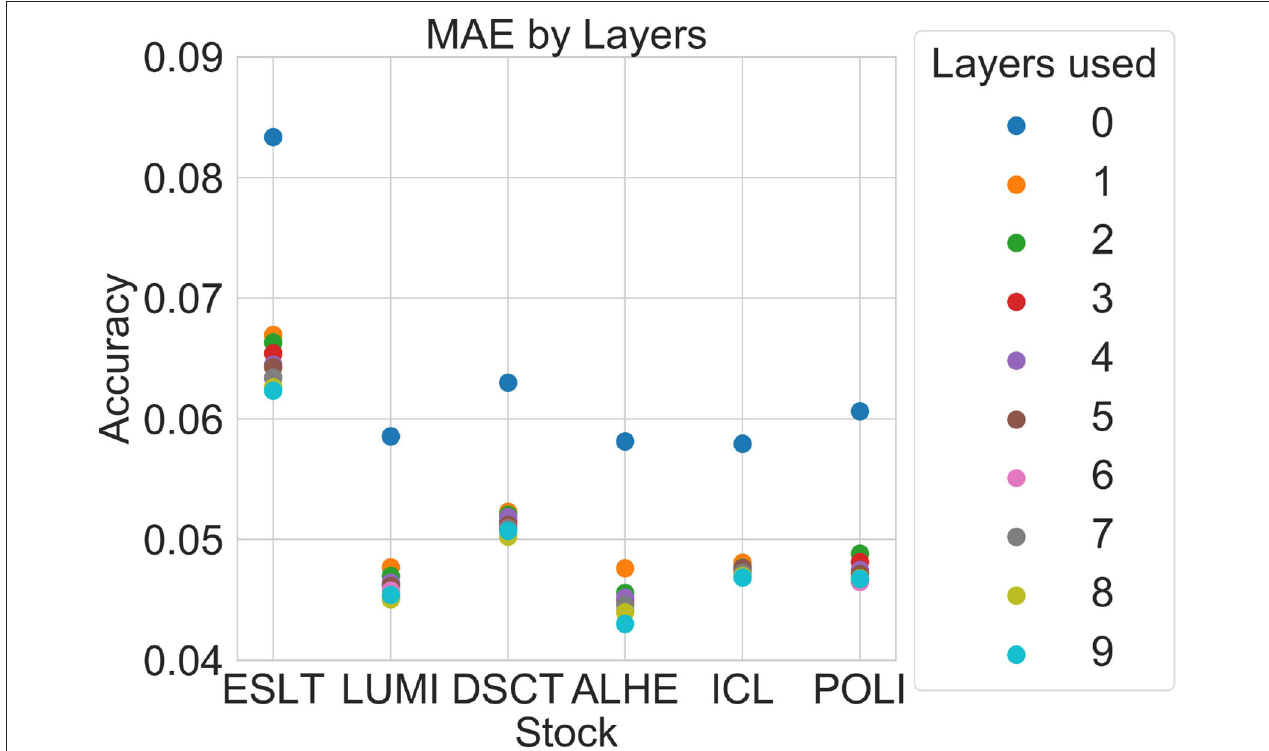
FIGURE 3 | MAE by number of